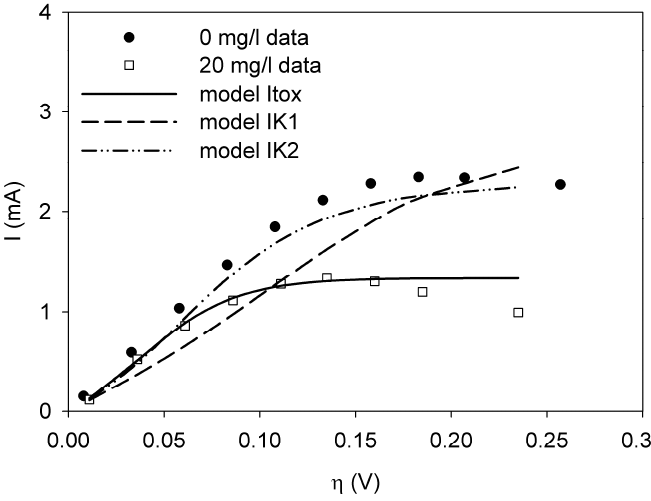
Figure 2. Polarization curves for a clean sensor (dots) and with 20 mg/L Ni present (squares). The data for 20 mg/L Ni were used to fit to model Itox (solid line), IK1 (dash), and IK2 (dot-dash-dot) using weighted least squares